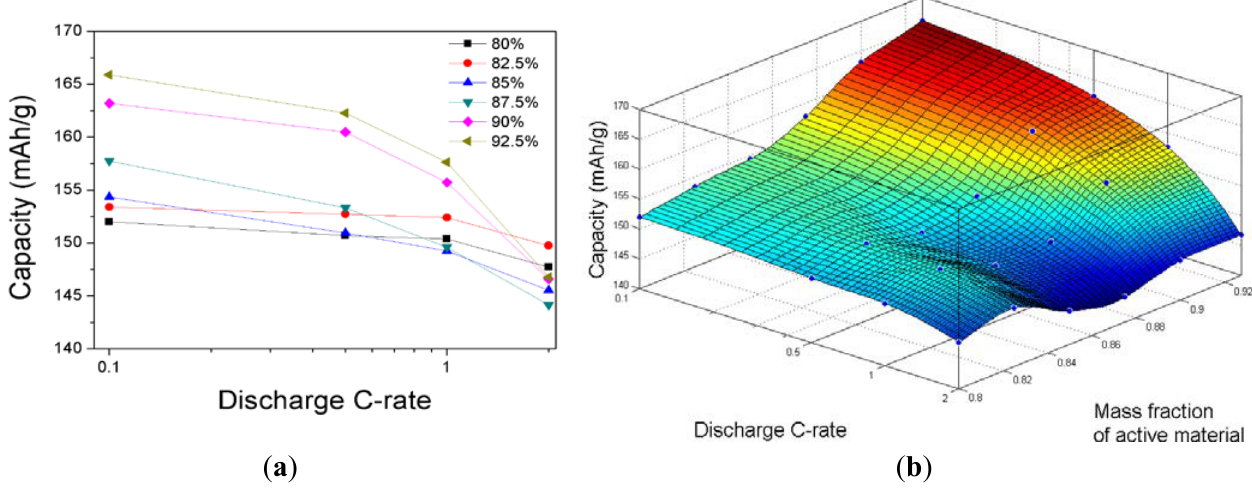
Figure 6. ( a ) Discharge capacities with discharge rates ranging from 0.1C to 2.0C for various cathode compositions; and ( b ) three-dimensional surface plot of the discharge capacity as a function of the discharge C-rate and the mass fraction of active material in the cathode.